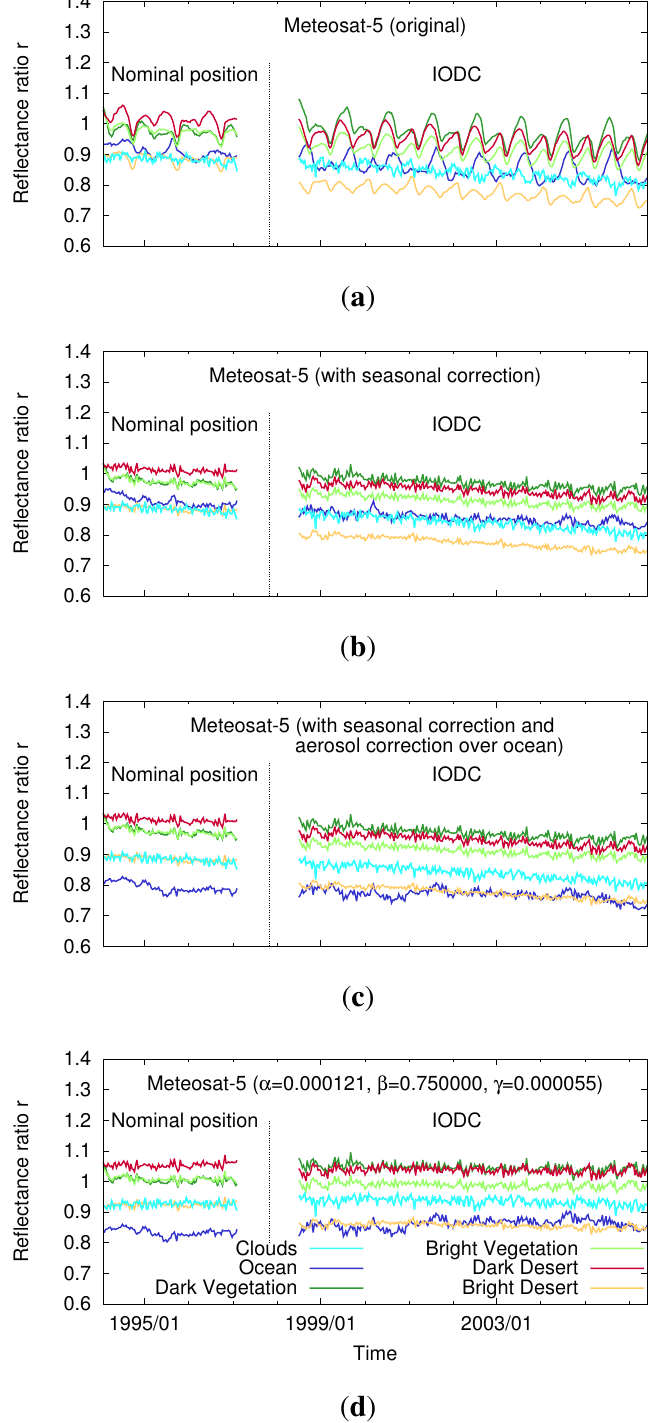
Figure 14. Meteosat-5 time series for the data coverage at 0 ◦ longitude, and the IODC at 63 ◦ E for ( a ) the original time series; ( b ) after seasonal correction; ( c ) after aerosol correction and ( d ) after ageing